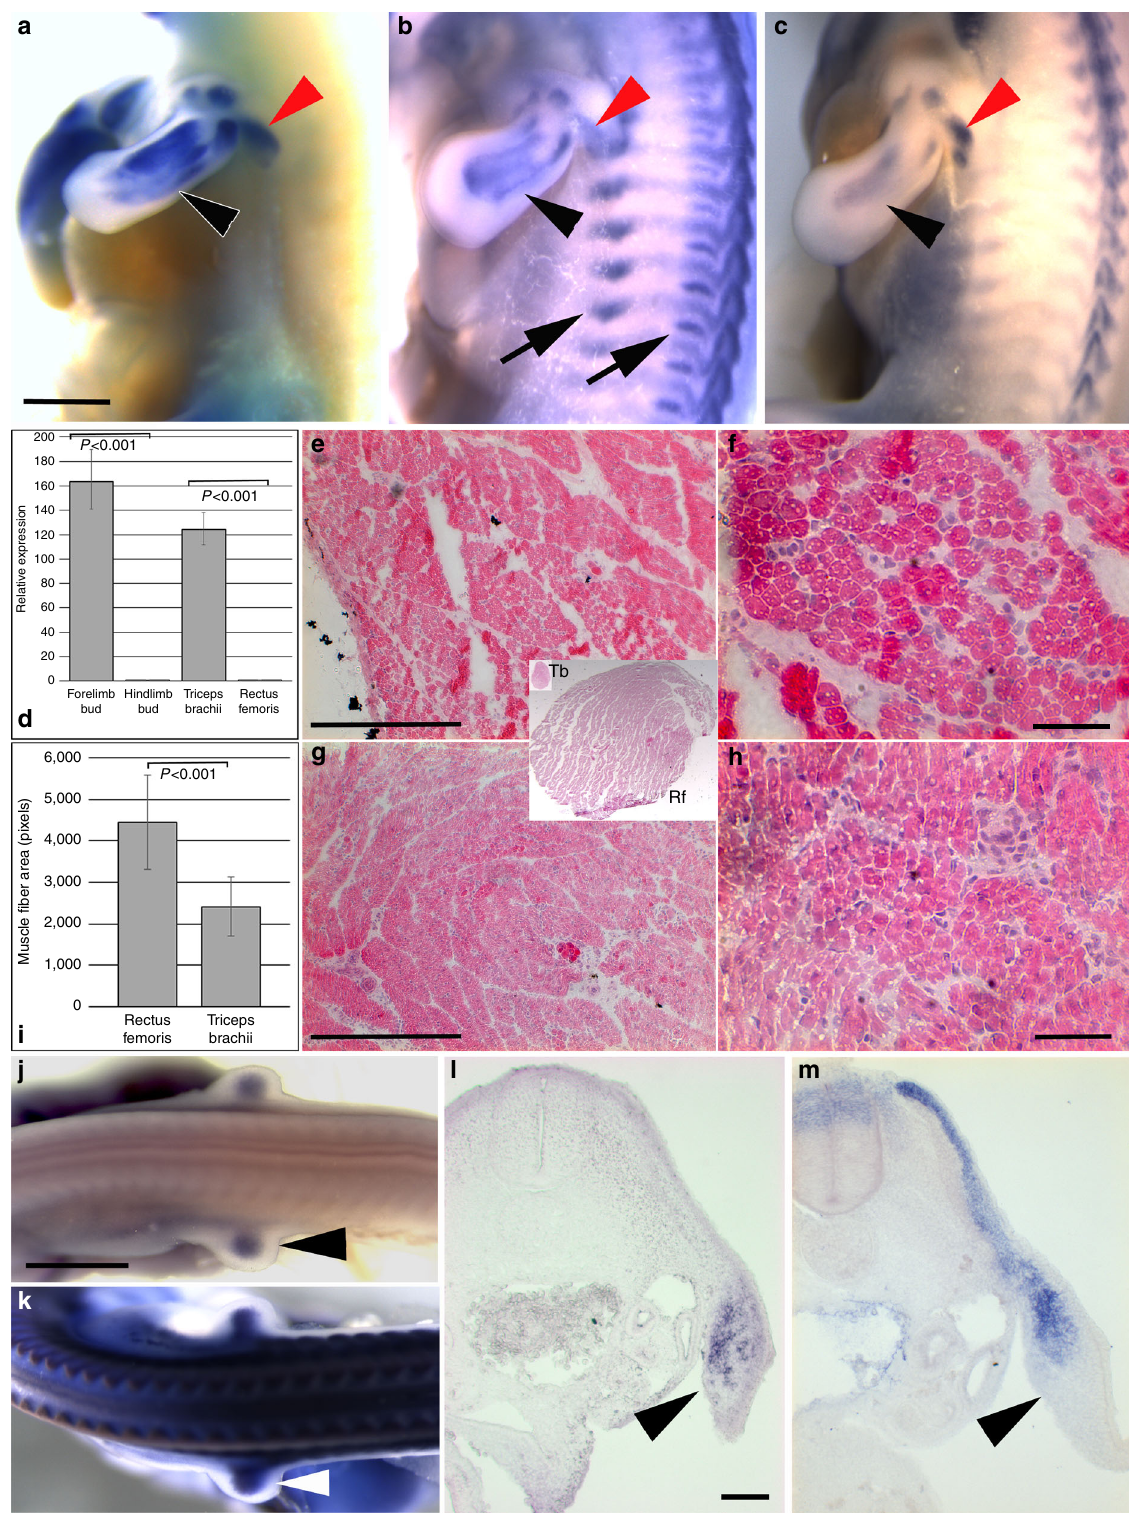
(Fig. 6a, b and Supplementary Fig. 5). Embryos infected with a control virus not harboring any exogenous gene exhibited com- parable morphology between infected and contralateral wings (Fig. 6c, d). At the digit condensation stage, Nkx2.5 expression resulted in a reduced autopod and a reduction in the size of the digit II and IV condensations with a relative sparing of the